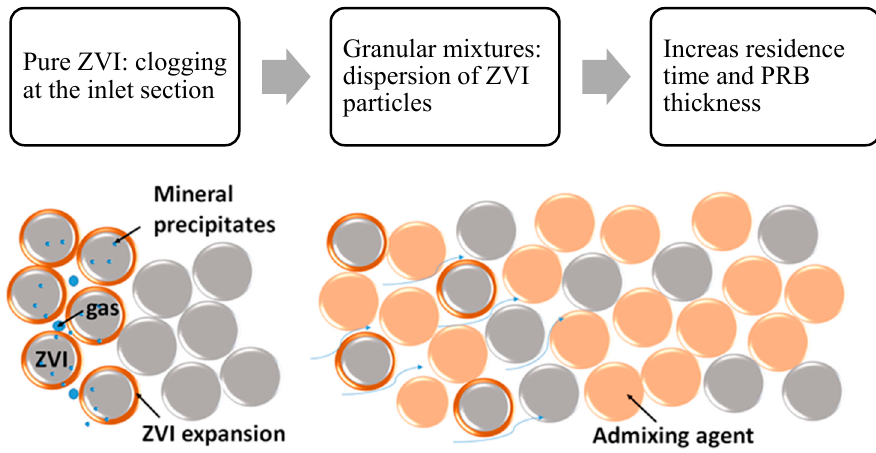
Figure 7. A schematic representation of the clogging phenomenon in pure ZVI and ZVI dispersed in an admixing agent.